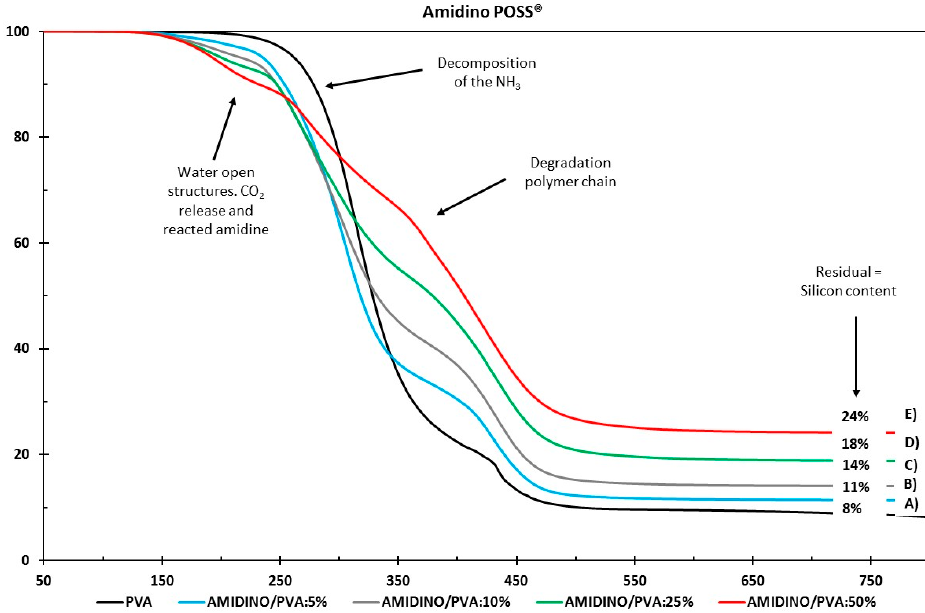
Figure 6. Thermogravimetric analysis of (A) PVA, Amidino POSS ® /PVA: (B) 5%; (C) 10%; (D) 25%; (E) 50%.